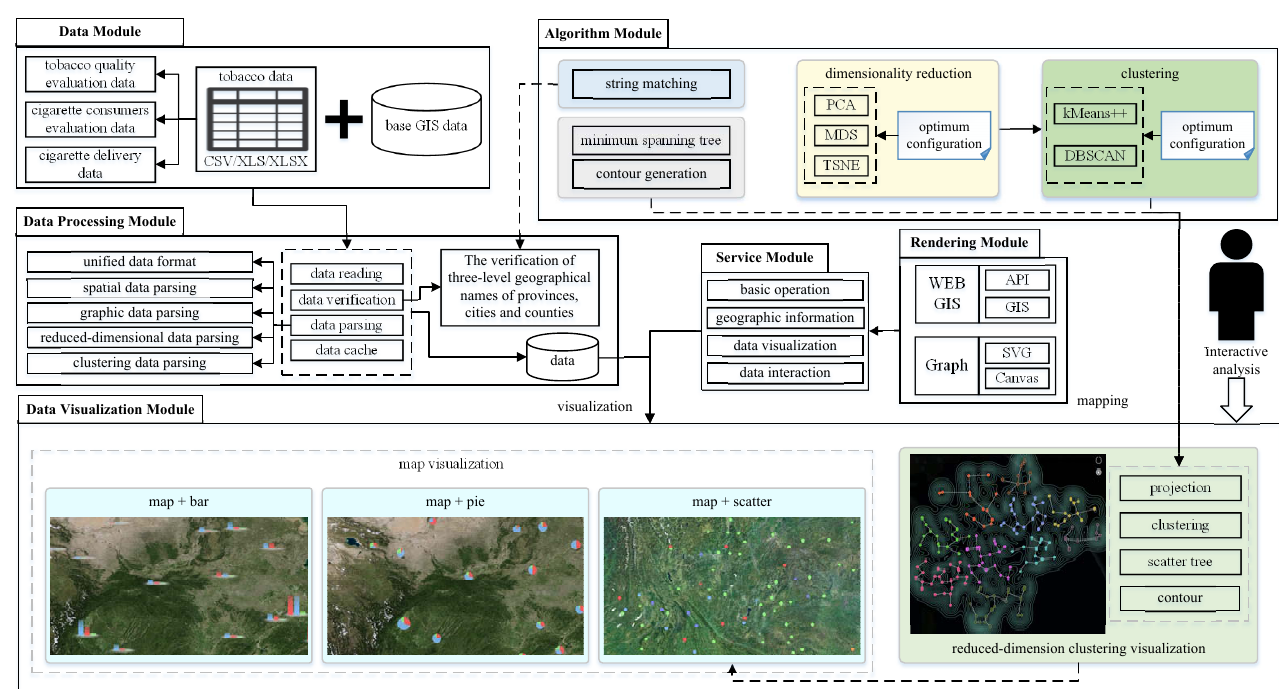
Figure 1. Visual